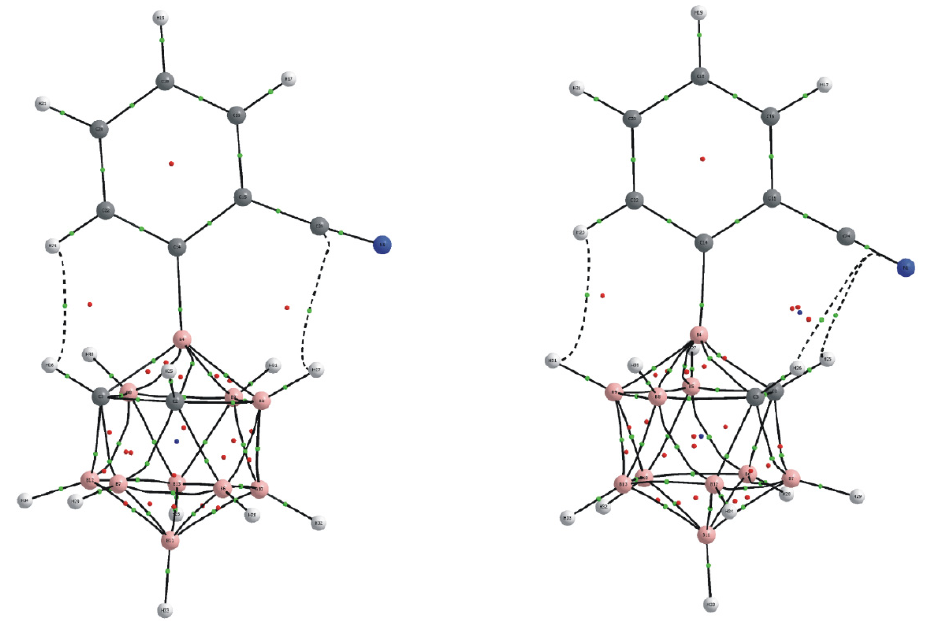
Figure 3. View of the molecular conformations corresponding to local ( left ) and global ( right ) minima for compound 6 .